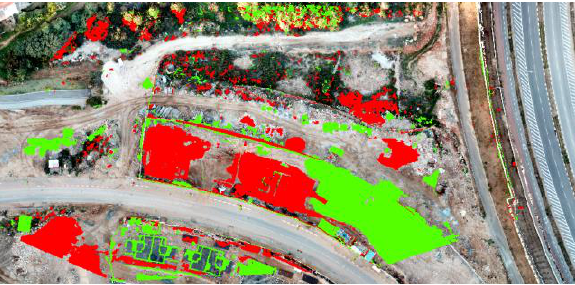
Figure 8. Identification of changes by the subtraction of DEMs after local affine transformation Increase in height above half a meter (green) Drop in height above half a meter